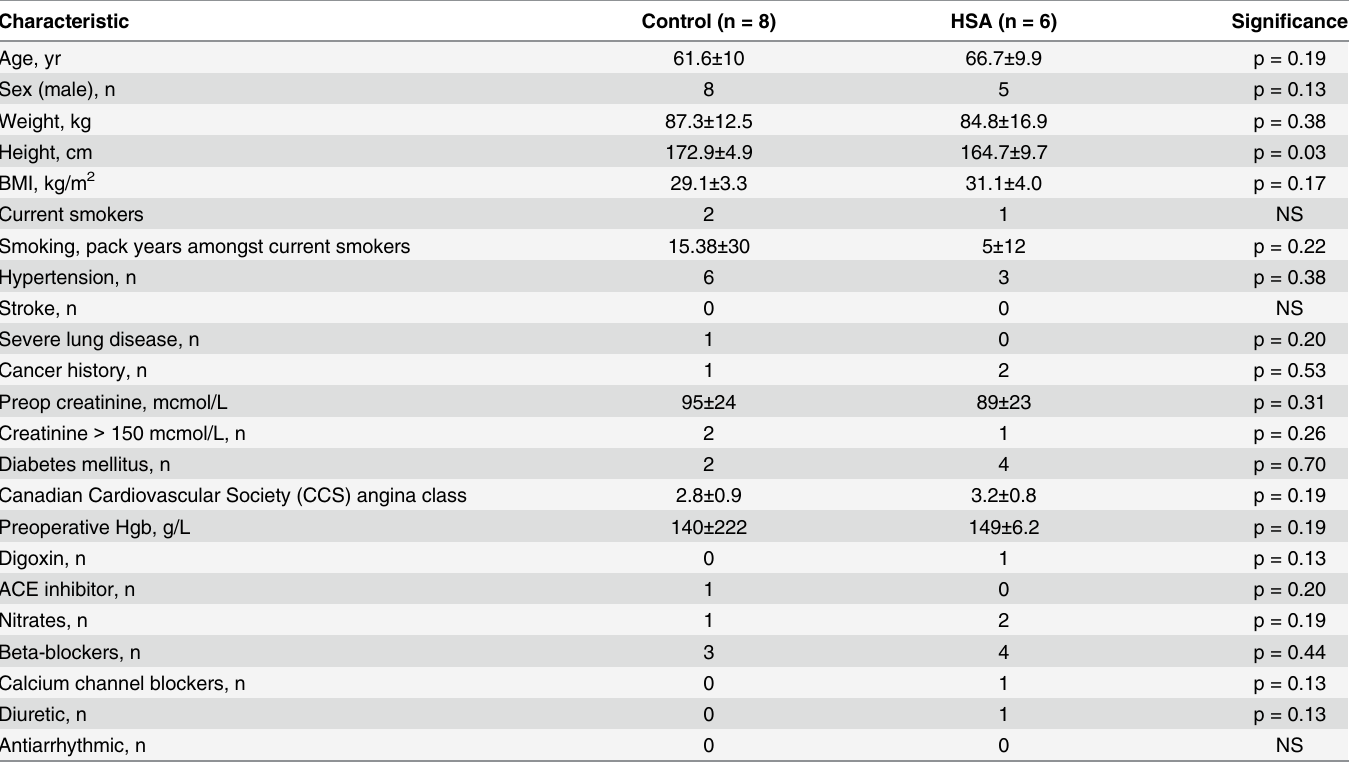
Table 1. Preoperative patient characteristics (mean ± SD).